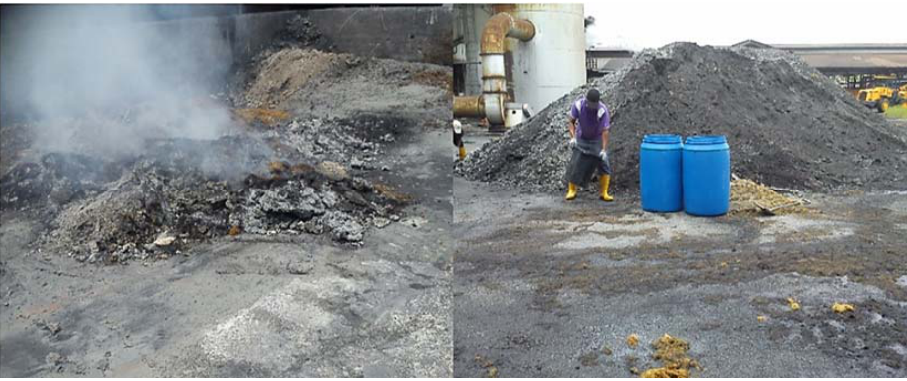
Figure 1. Solid waste of palm oil mill.